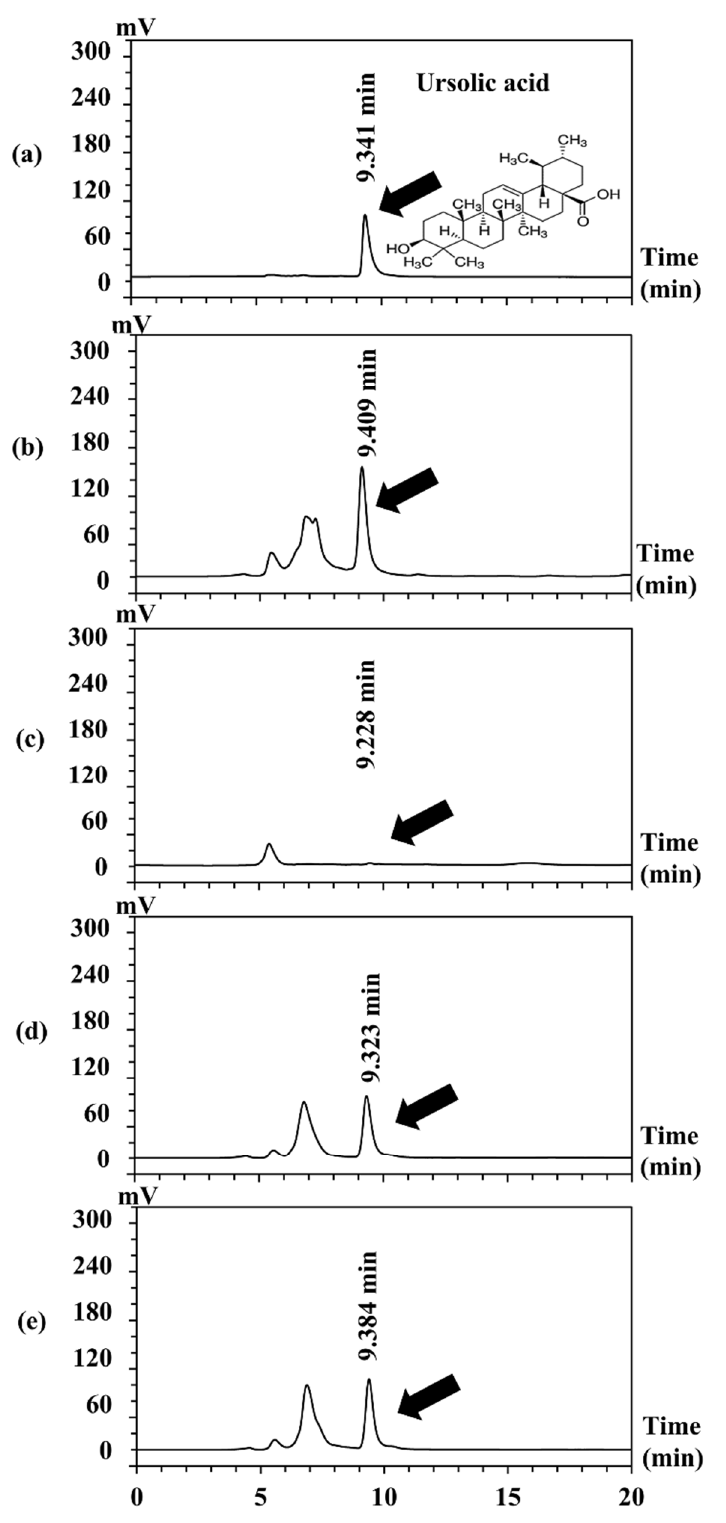
Figure 3. HPLC chromatograms of ursolic acid ( a ) and ethyl acetate extracts from various parts of C. carandas , i.e., leaf ( b ), seed ( c ), pulp ( d ), and fruit ( e ). On the other hand, among various part of C. carandas extracted using n -hexane, HL contained the significantly highest ursolic acid (8.77 mg/g extract) ( p < 0.05), whereas HF (2.54 mg/g extract), HP (1.60 mg/g extract), and HS (0.55 mg/g extract) contained